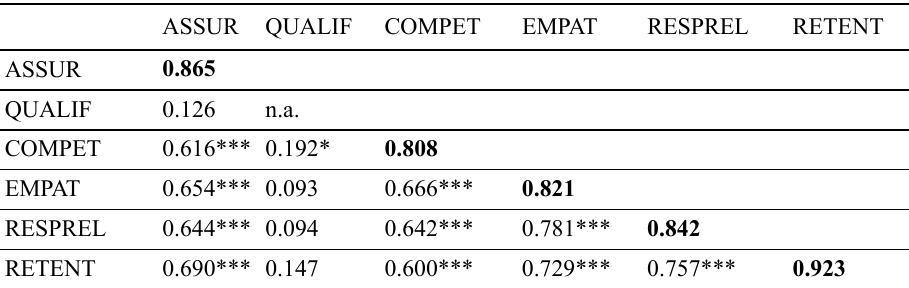
Table 4. Correlation